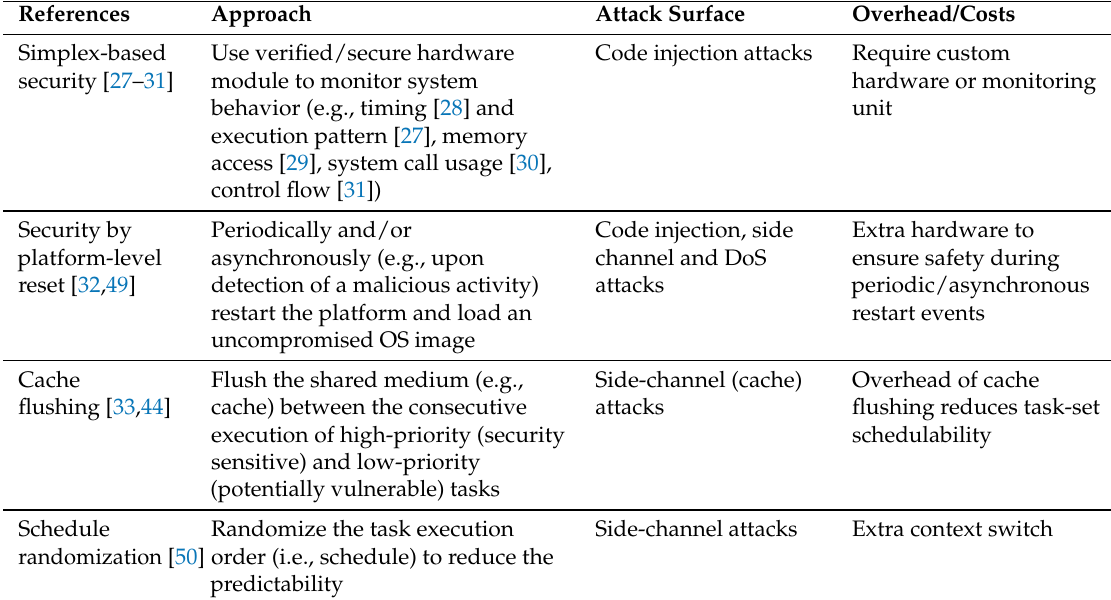
Table 2. Summary of Security Solutions for